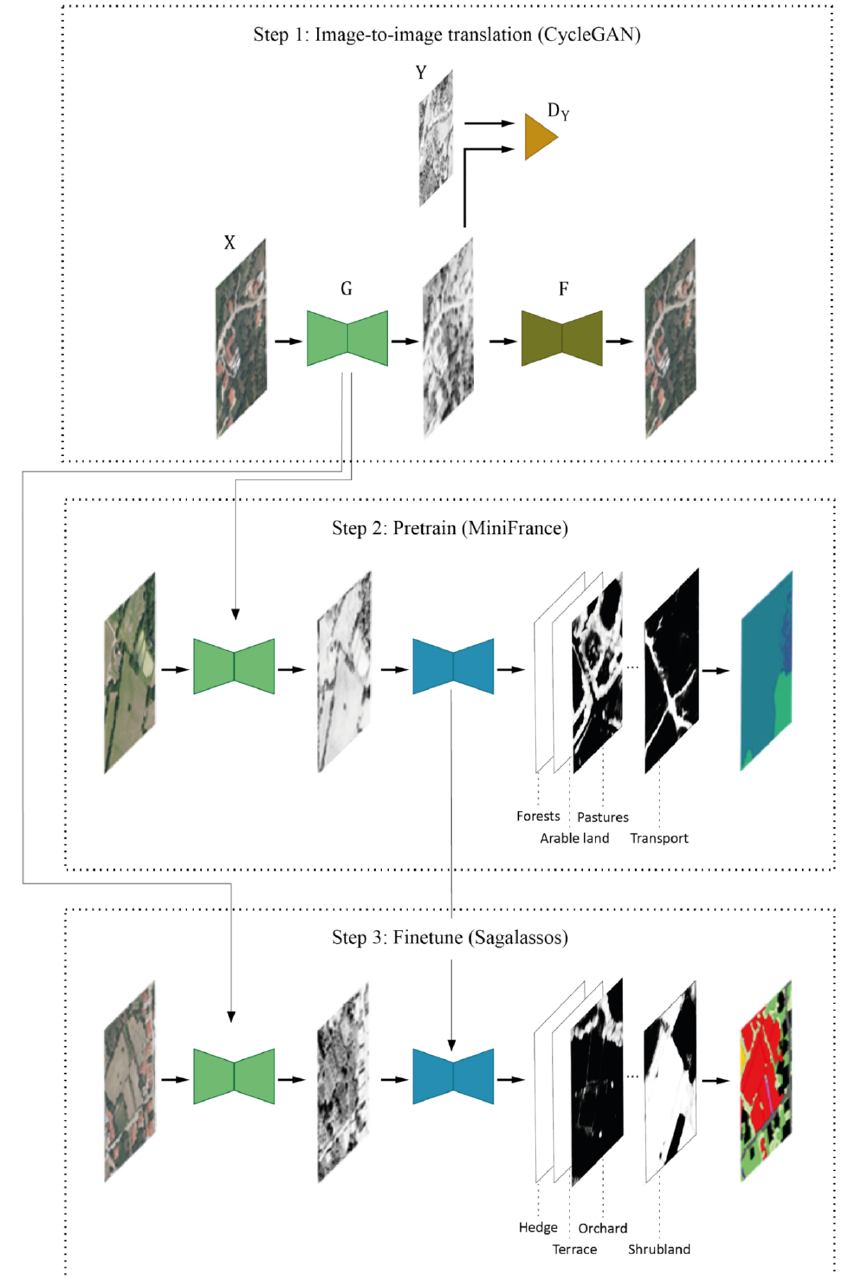
Figure 4. Training procedure for semantic segmentation of historical orthophotos partitioned